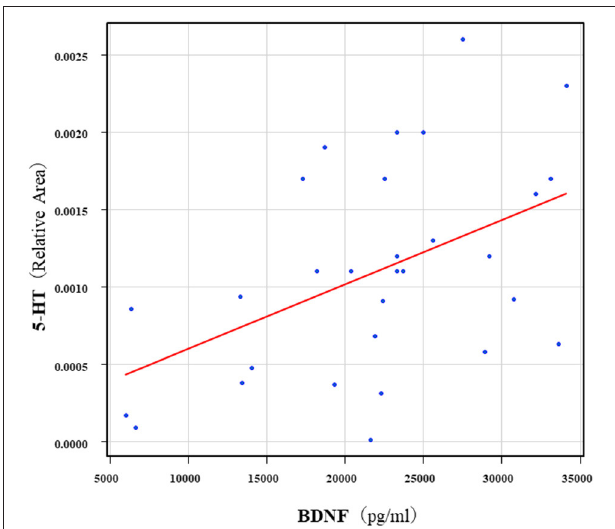
FIGURE 3 | Association between serum 5-HT levels and serum BDNF levels in the schizophrenia group 5. A significant positive correlation was found between the serum BDNF level and the serum 5-HT levels ( r = 0.49, p = 0.0061) in the schizophrenia group. Relative Area: The peak areas of the metabolites were normalized against those of the internal standards, and the resultant relative areas were further normalized by the sample amount explained in the Measurement of metabolites of the Kyn pathway. Thus, serum 5-HT levels demonstrated as the ratio comparing with internal standard.